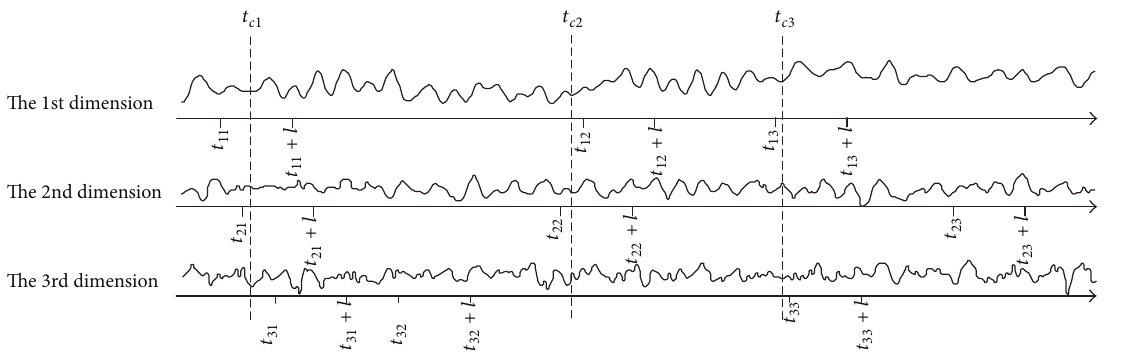
Figure 2: Truncating similar sequences for subsequence